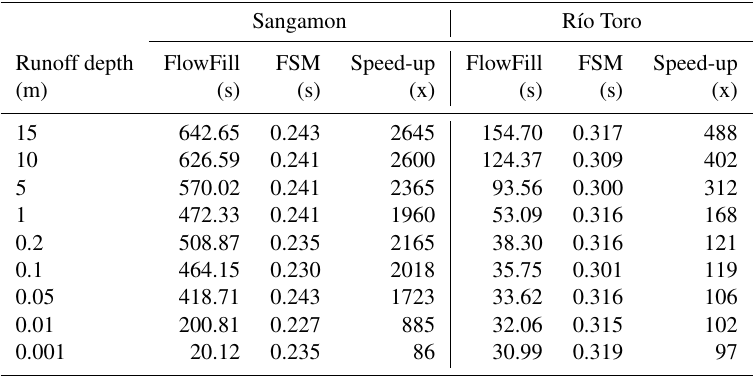
Table 2. Time comparison of Fill–Spill–Merge vs. FlowFill. Wall times are in seconds comparing FlowFill (Callaghan and Wickert, 2019) parallelized across 24 cores versus Fill–Spill–Merge on a single core; “speed-up” is a multiplicative factor. Using FlowFill, wall times increased with the depth of applied runoff and on flatter landscapes. Using FSM, wall time is independent of the depth of applied runoff and ruggedness of the landscape, but it increases for larger domains. FSM’s wall times were 86–2645 times faster than FlowFill for these examples; compute times were 2064–63480 times